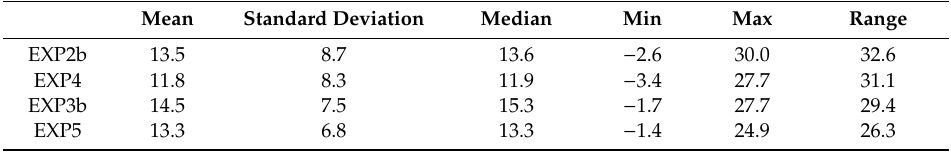
Table 23. TS ( ◦ C) (0–10 cm) simulated by UTOPIA and NOAH, initialized with GLDAS, at the FU